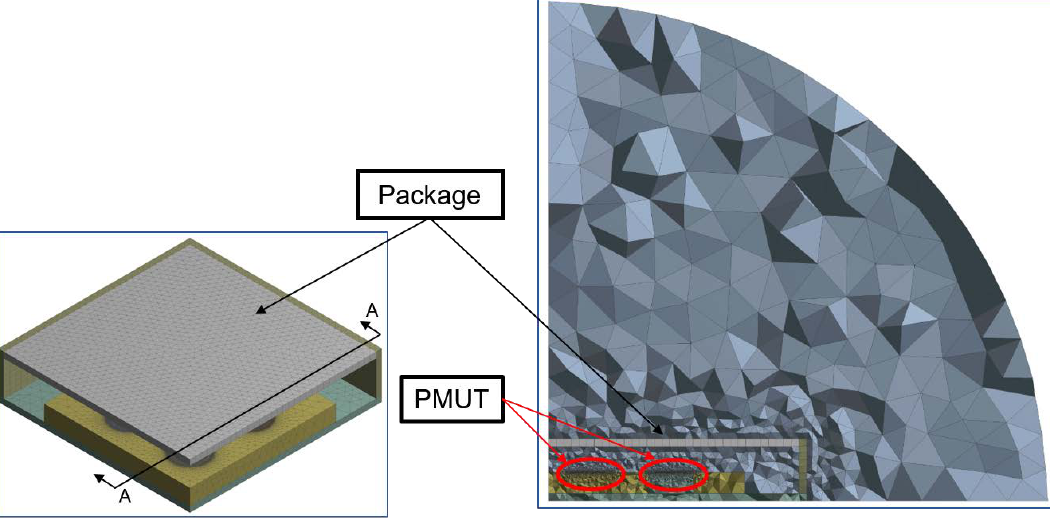
Figure 6. Mesh details: packaged transducer with no hole ( left ), vertical cross-section along A-A of the solid and acoustic domains ( right